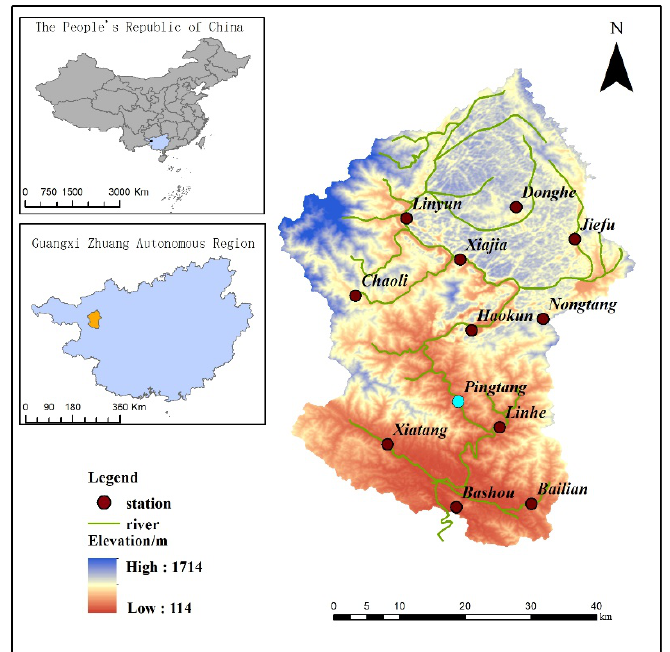
Figure 2. Chengbi River karst basin.